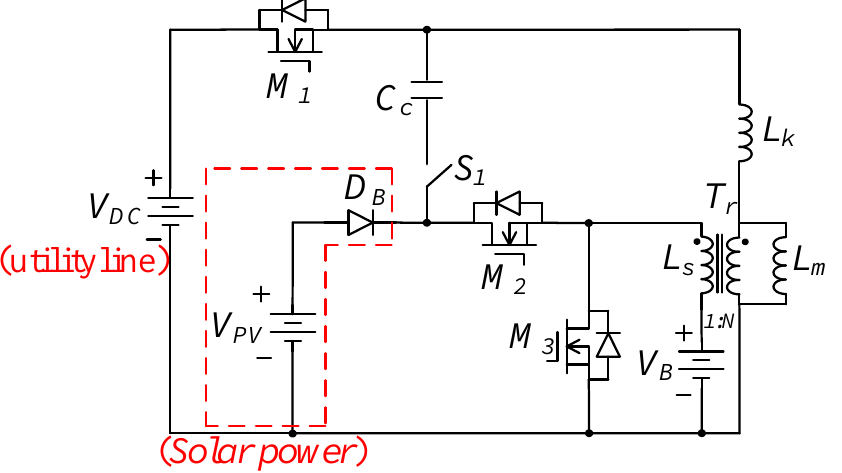
Figure 4. Schematic diagram of the proposed hybrid converter. The multiport converter has been widely applied to generate electric power